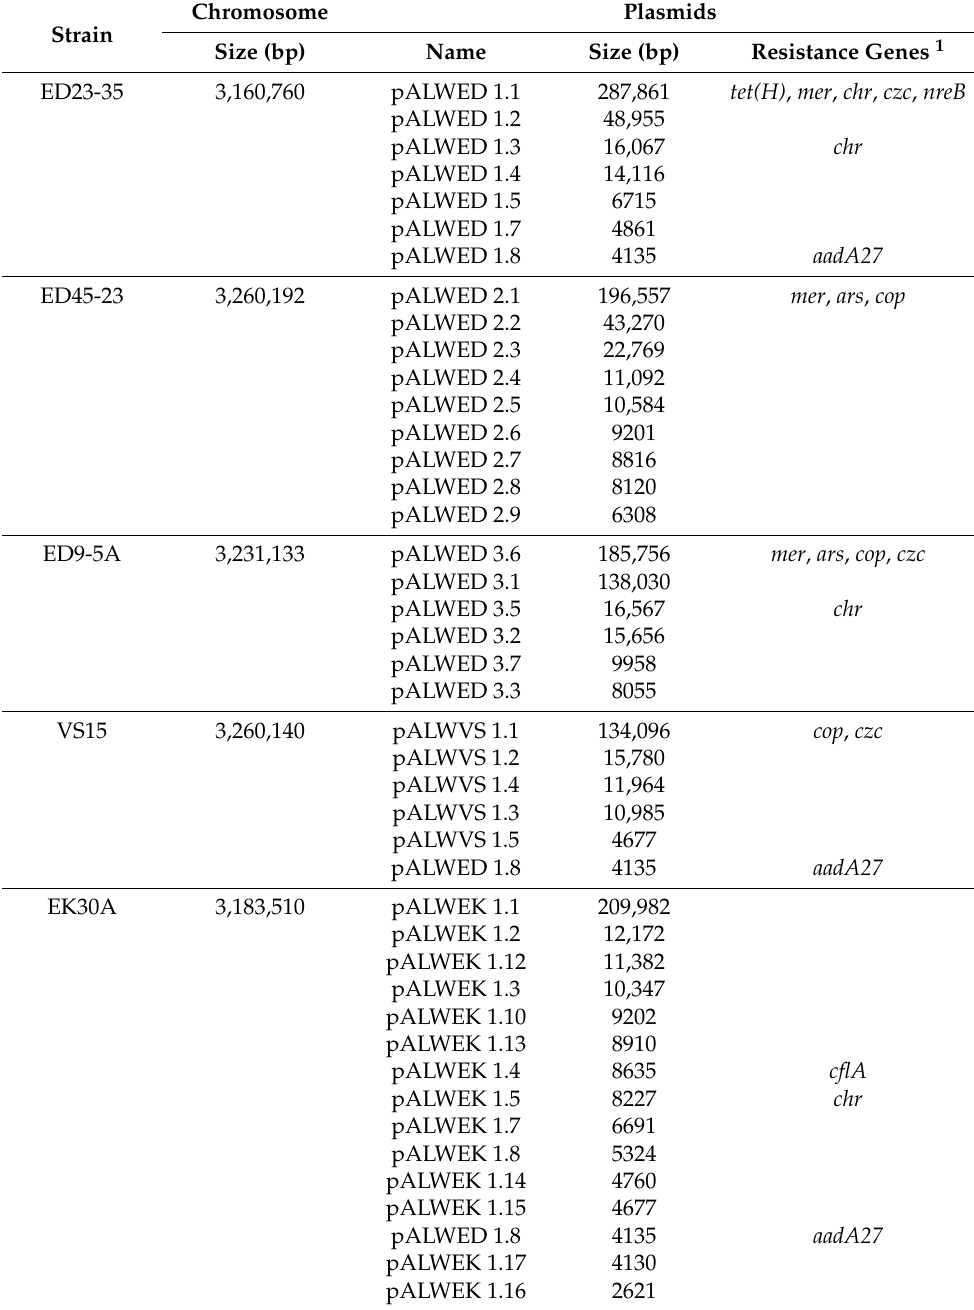
Table 2. Genomes of permafrost strains of A. lwoffii